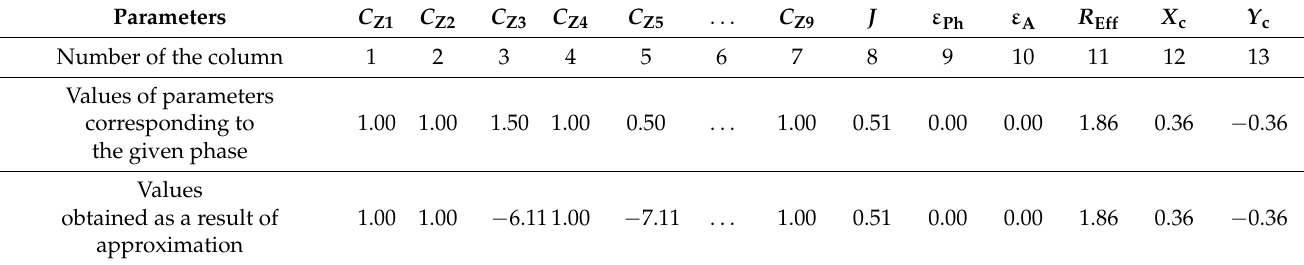
Table 2. The screen was set by 9 polynomials and approximated by 9 polynomials. Dimensions of computational grid are 256 × 256